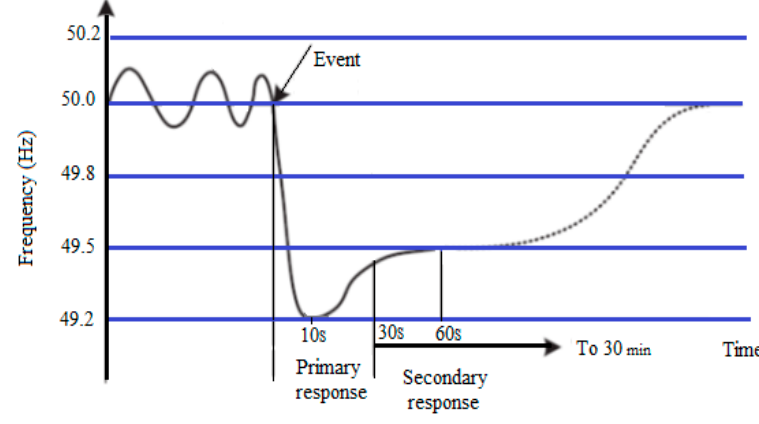
Figure 16. Modes of frequency control in Great Britain.